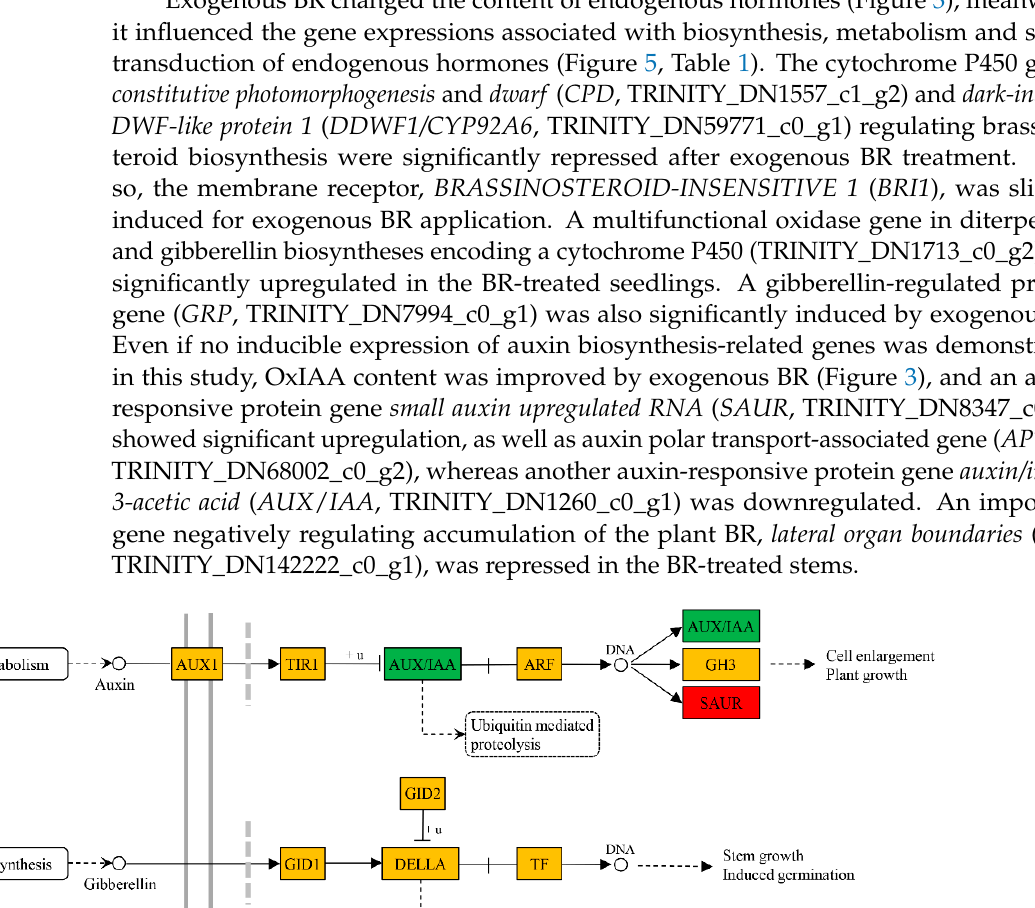
H 2 O treatment. Red and green dots indicate the up- and down-regulated genes, respectively. ( C ) Top 20 of GO enrichment analysis of DEGs for cellular component, biological process and molecular function. ( D ) KEGG enrichment of DEGs. The size of dots represents the gene number, and color of dots represents the FDR value.